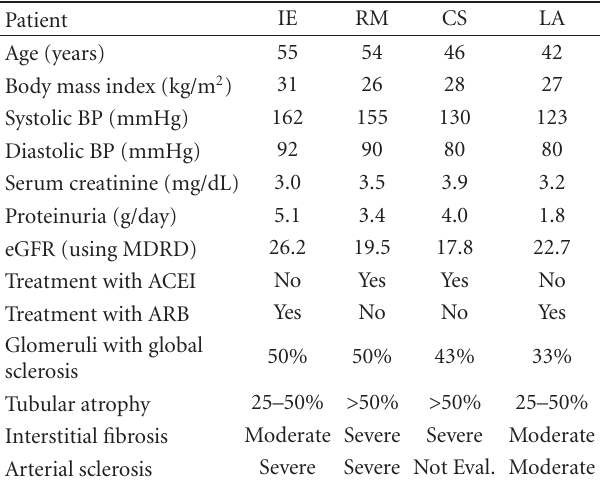
Table 1: Baseline clinical and histological characteristics of the four